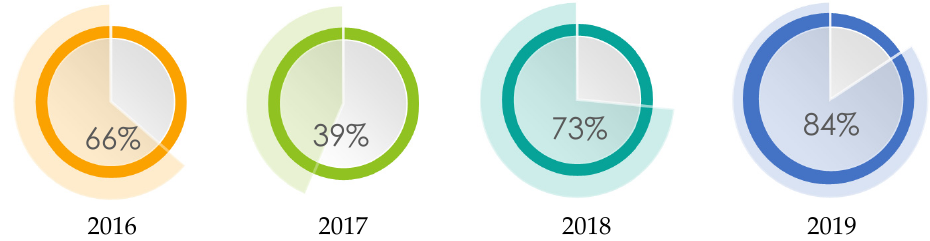
Figure 1. Percentage of scholars whose articles were published in English and international journals.